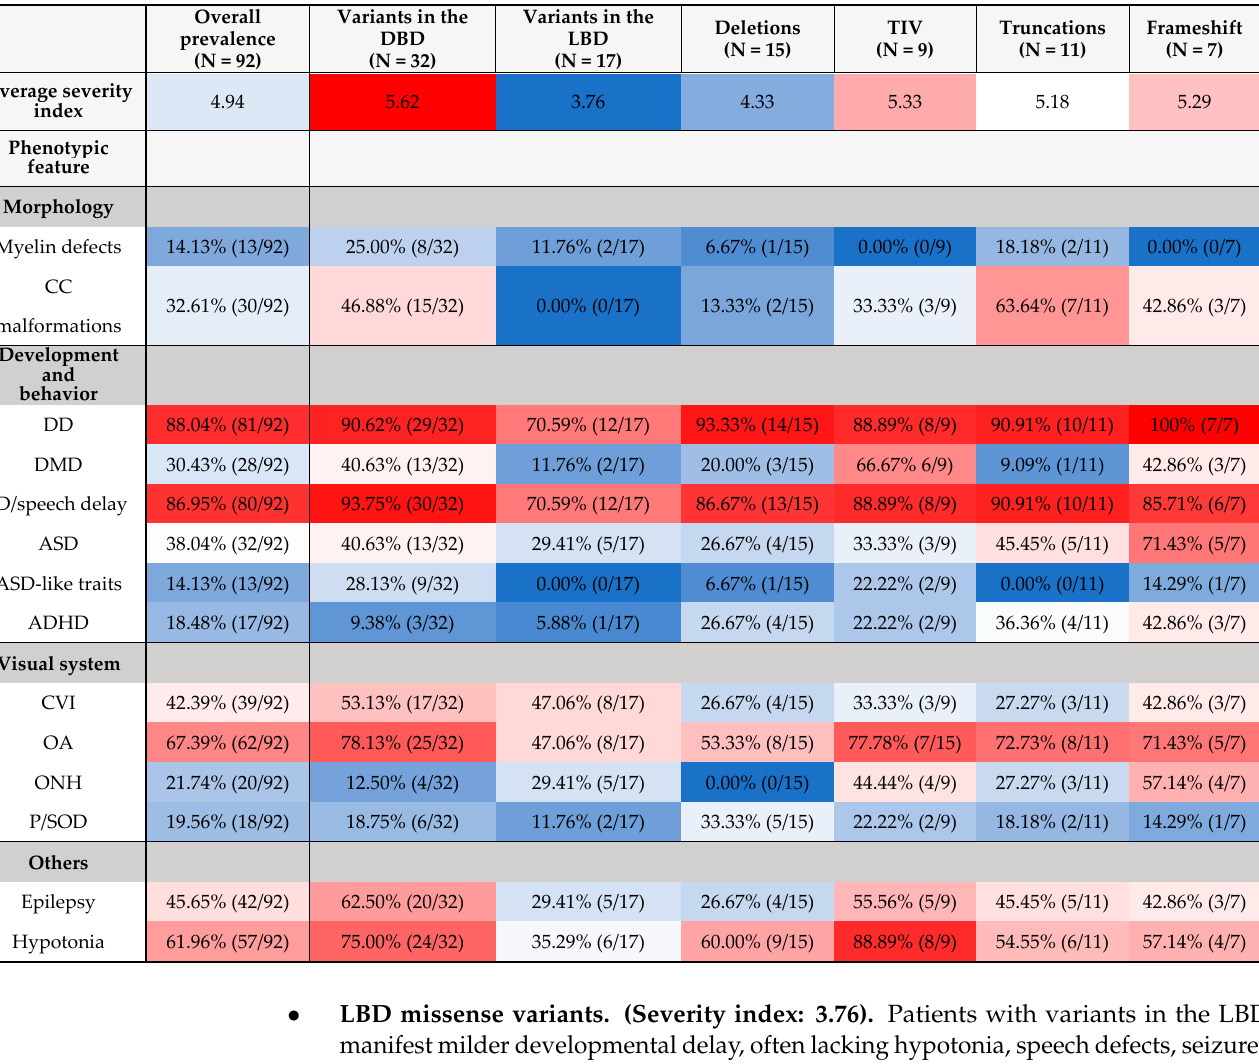
assays to be confirmed and characterized. The exact 3D structure of nuclear receptor dimers and their formation rate, the identity of NR2F1 cofactors and the possible toxic effect of frameshift/truncated variants will require further studies. The asterisks indicate point mutations (color-coded following their genetic category), whereas stop symbols (in red and white) represent truncation sites. Table 5. Symptom prevalence: overall and by variant type. Table shows the prevalence of specific morphological and pathological features (lines) in BBSOAS patients, as a whole (first column), or in distinct BBSOAS genetic categories (second to seventh columns), as indicated. The prevalence of each symptom is calculated as a percentage of positive cases above the total number of patients for that category (numbers of patients are indicated in parenthesis). The color code refers to the severity of prevalence, from higher incidence (red) to lower prevalence (blue). Abbreviations: DBD, DNA binding domain, LBD, ligand binding domain; TIVs, translation initiation variants; CC, corpus callosum; DD, developmental delay; DMD, delayed motor development; ID, intellectual disability; ASD, autism spectrum disorder; ADHD, attention deficit hyperactivity disorder; CVI, cortical visual impairment; OA, optic atrophy; ONH, optic nerve hypoplasia; P/SOD, pallid or small optic